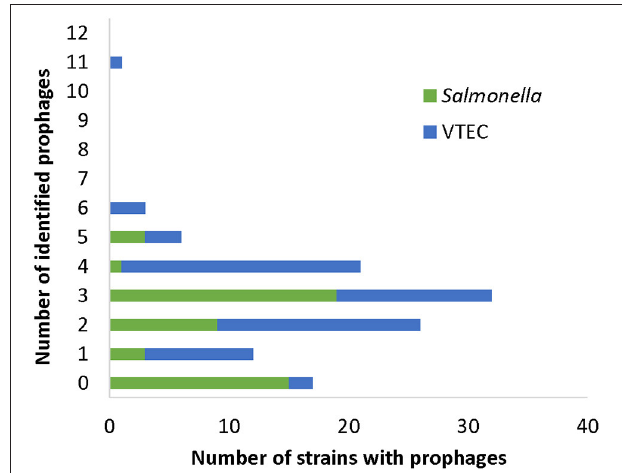
FIGURE 2 | Frequency histogram of strains carrying prophages.